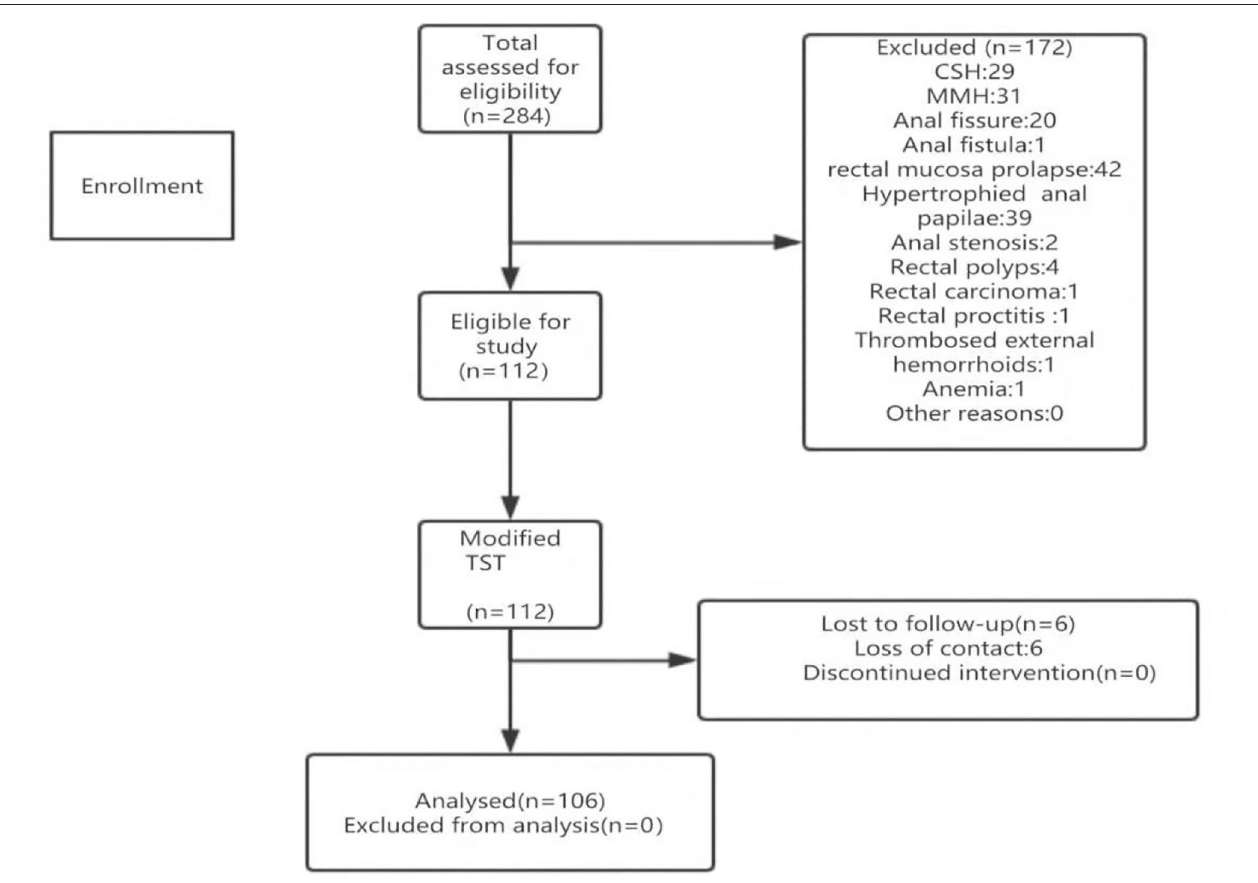
FIGURE 4 | Participant enrollment and follow-up. CSH, circumferential stapled hemorrhoidopexy; MMH, Milligan-Morgan hemorrhoidectomy; TST, Tissue selecting technique.